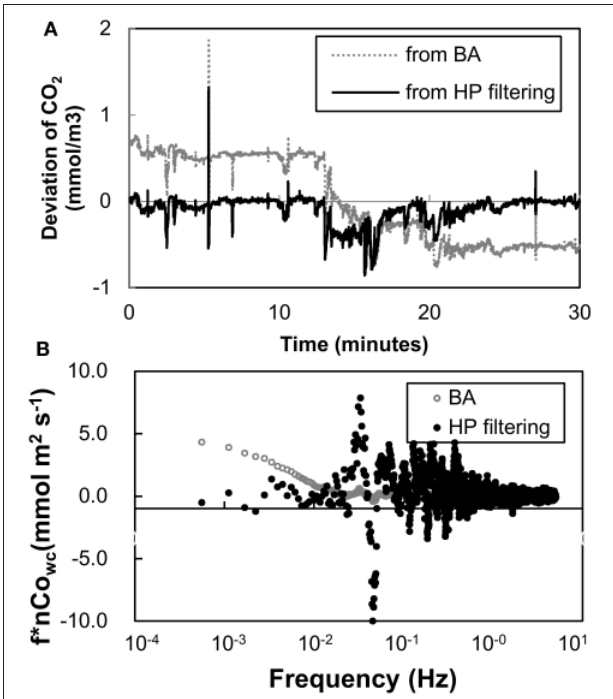
FIGURE 8 | Examples of the deviation calculations of atmospheric CO 2 concentration (A) and the cospectrum of atmospheric CO 2 concentration and vertical wind speed (B) . The cospectrum density was normalized by each covariance of CO 2 and vertical wind